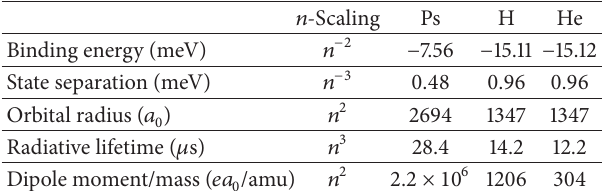
Table 2: The 𝑛 -dependence of several properties of Rydberg atoms, with examples shown for the 30 d state of Ps, H, and He. The state separation is calculated for 30 d → 31d. The orbital radius is defined − 𝑙(𝑙 + 1)) , where 𝑛 here as the expectation value ⟨𝑟⟩ = (1/2)(3𝑛 2 eff eff includes the relevant quantum defect. The electric dipole moment- to-mass ratios are calculated for the outermost state of the 𝑛 = 30, 𝑚 = 2 Stark manifold. The radiative lifetime 𝑛 -dependence applies only to low 𝑙 states: for circular states, the scaling is closer to 𝑛 5 (see Figure